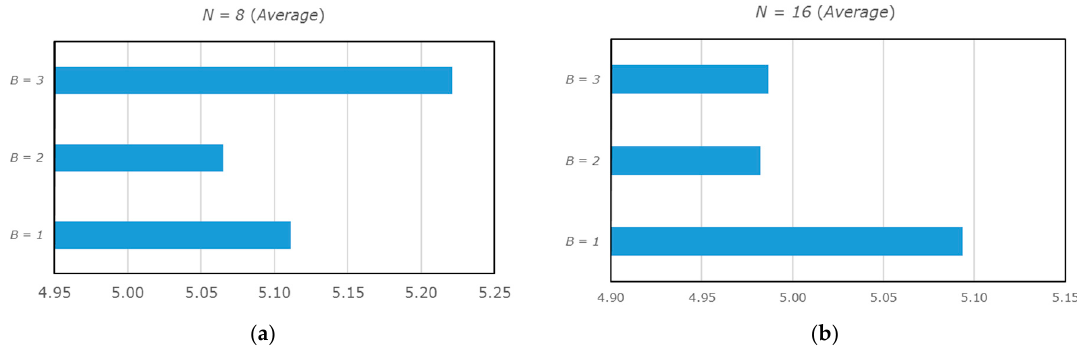
Figure 4. Graphical representation of the average results by using the AC scheme for the coding of the prediction errors. (cid:1840) = 8 ( a ) and (cid:1840) = 16 ( b ).